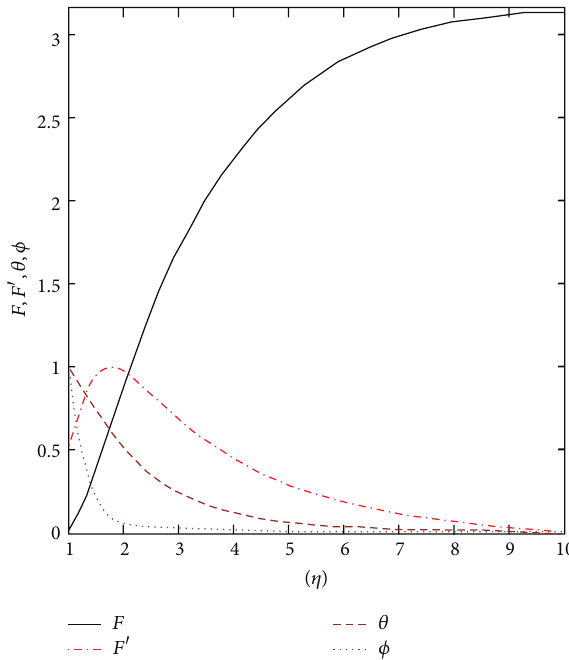
Figure 2: Plots of dimensionless similarity functions 𝐹(𝜂) , 𝐹 󸀠 (𝜂) , 𝜃(𝜂) , and 𝜙(𝜂) for the case of Le = 10, Nr = 0.5, Nb = 0.5, Nt = 0.5, and 𝜁 = 1 .